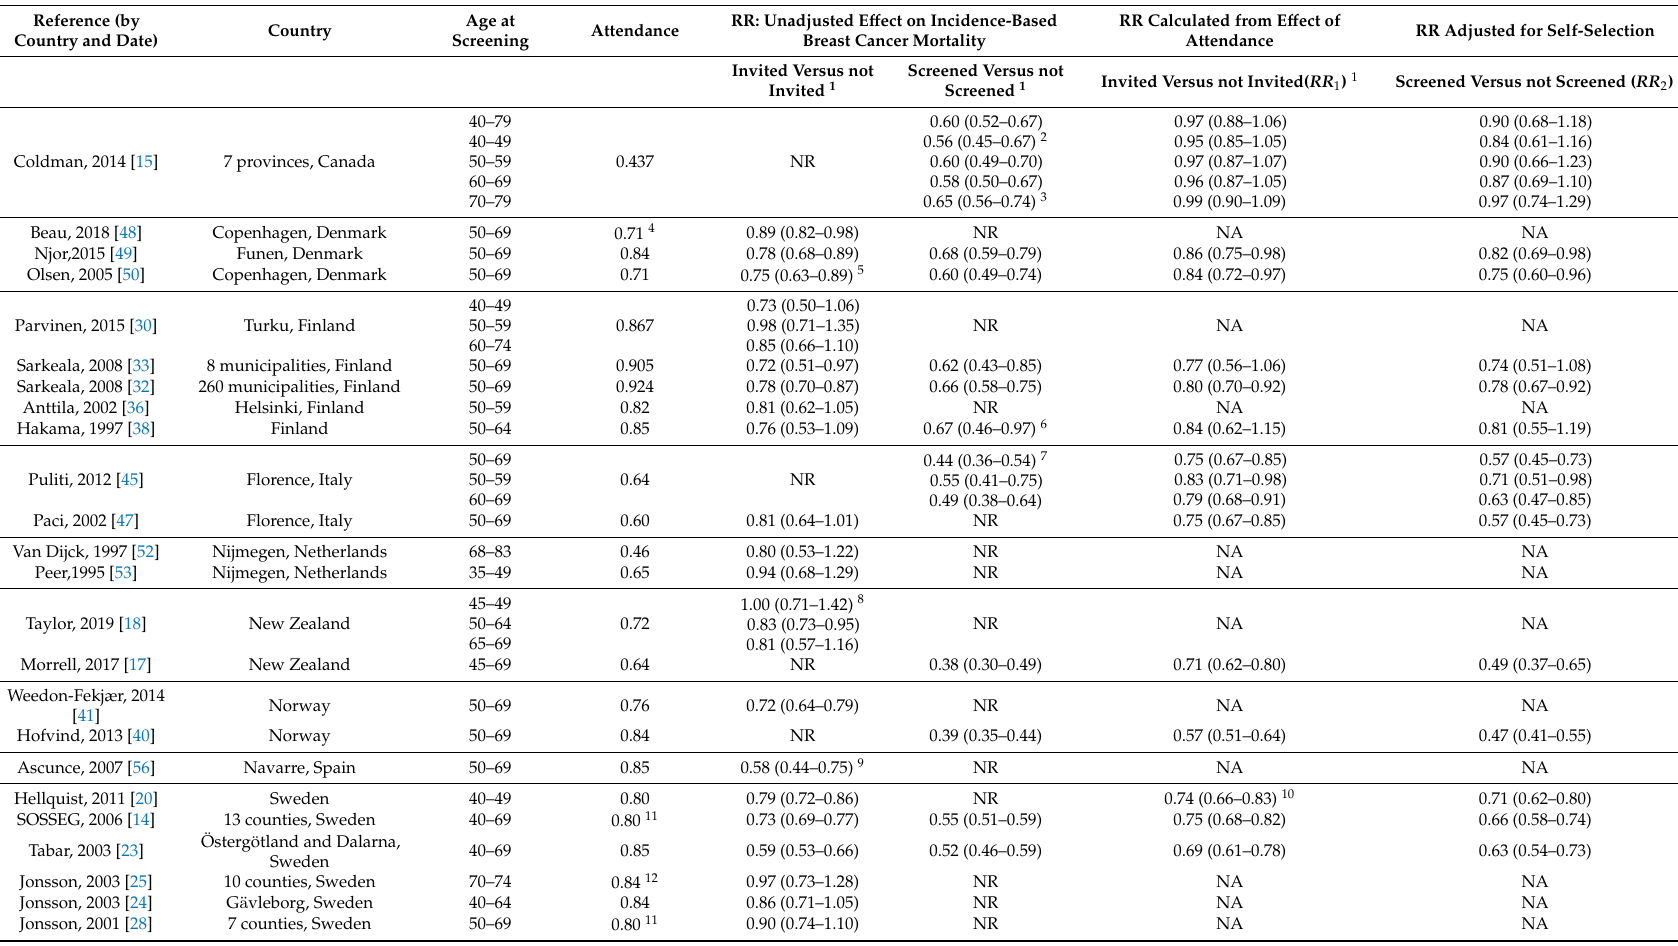
Table 3. Unadjusted and adjusted relative